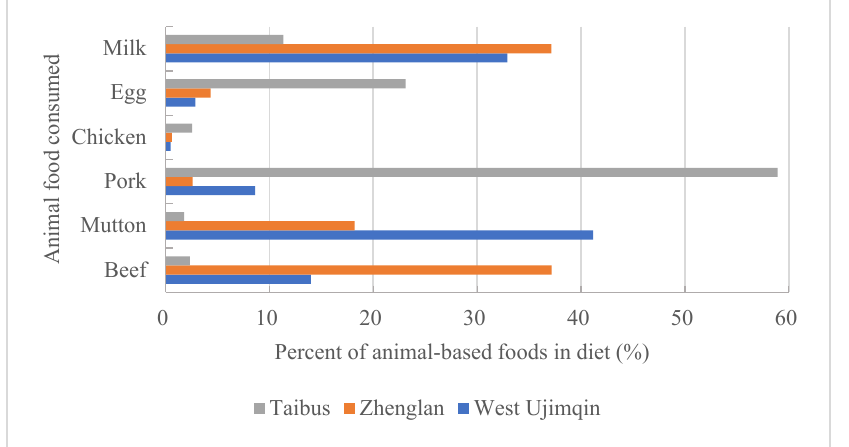
Figure 4. A comparison of plant-based food consumption in the three banners.